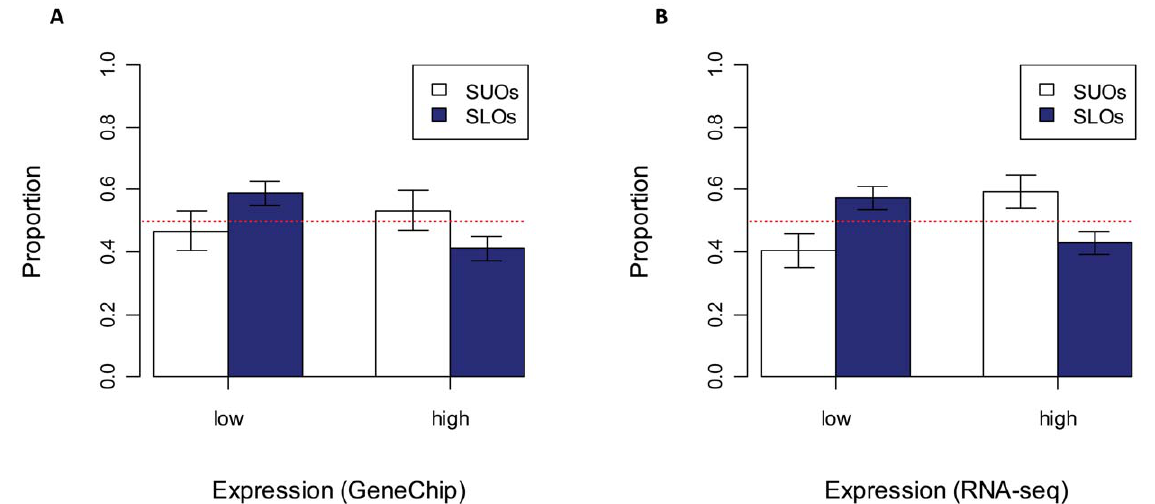
Figure 6. Gene expression data analyses for SUOs and SLOs in mouse ESCs. (A) Gene expression data based on GeneChip technology. (B) Gene expression data based on RNA-seq technology. In both (A) and (B), SUOs and SLOs are divided into ‘low’ and ‘high’ expression genes in mouse ESCs based on the median expression level of all genes . 10 kb. The red dotted line shows the 50% level, which is the proportion taken by lowly/ highly expressed genes for all genes . 10 kb in mouse ESCs. Error bars are standard errors derived from the total number of genes (sample size) in each gene set.